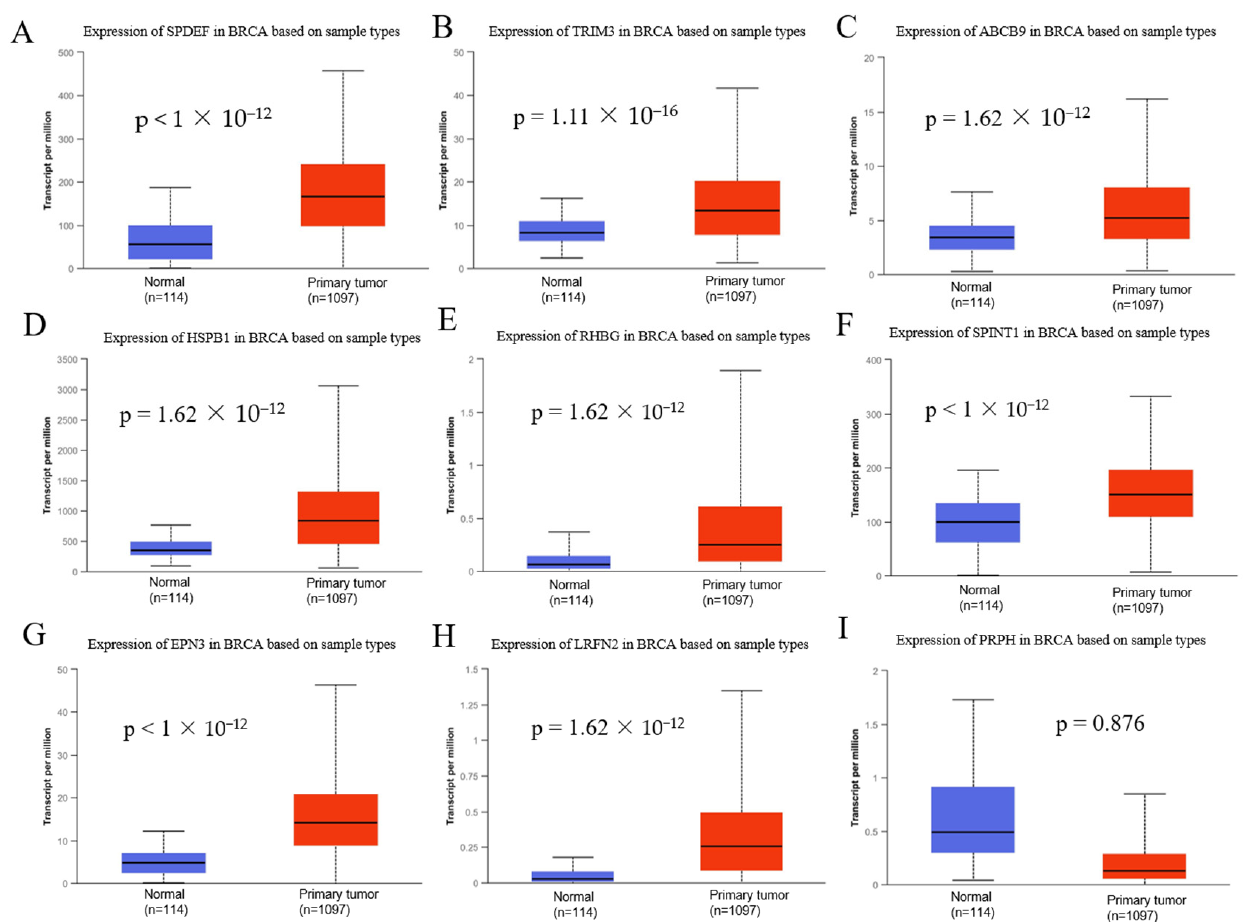
Figure 4. Validation of the expression of nine candidate genes in TCGA_BRCA samples and normal tissues using UALCAN. ( A ) SPDEF , ( B ) TRIM3 , ( C ) ABCB9 , ( D ) HSPB1 , ( E ) RHBG , ( F ) SPINT1 , ( G ) EPN3 , ( H ) LRFN2, and ( I ) PRPH .